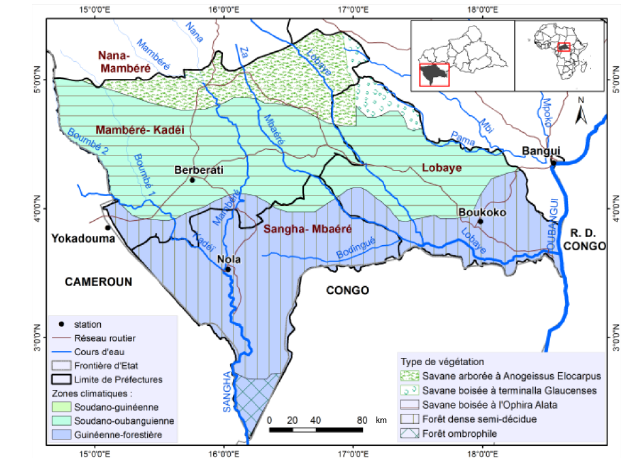
Figure 1. Localisation du Sud-ouest centrafricain. © Atlas of the Central African Republic